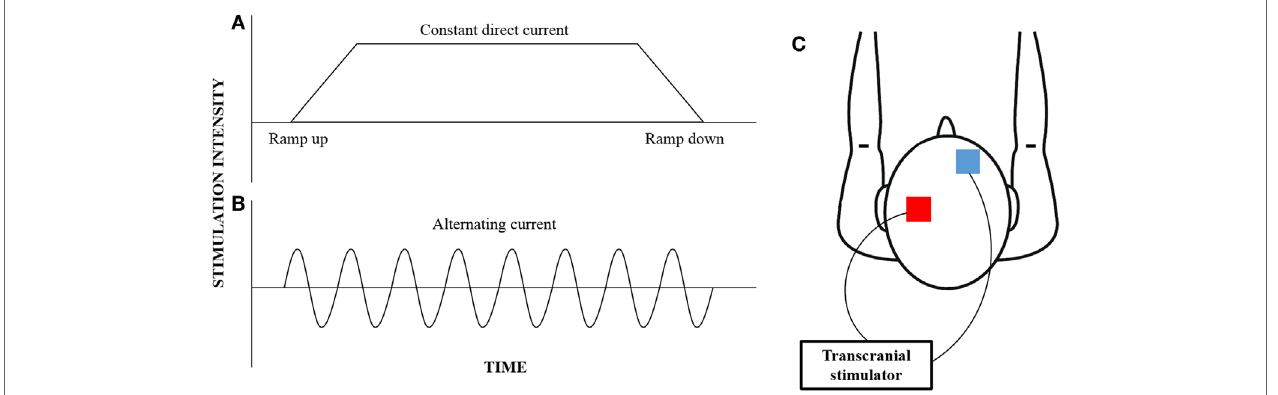
FigURe 1 | An illustration of the different current waveforms that can be provided by transcranial stimulation . Convention transcranial direct current stimulation (A) provides constant current that begins with a ramp-up phase and ends with a ramp-down phase; however, transcranial alternating current stimulation (B) provides a rhythmic waveform that can be customized to target specific neural oscillations. While the electrodes (red—anode; blue—cathode) are typically placed over the motor cortex and the contralateral supraorbital region (C) , the electrode montage can be customized to target any cortical region of